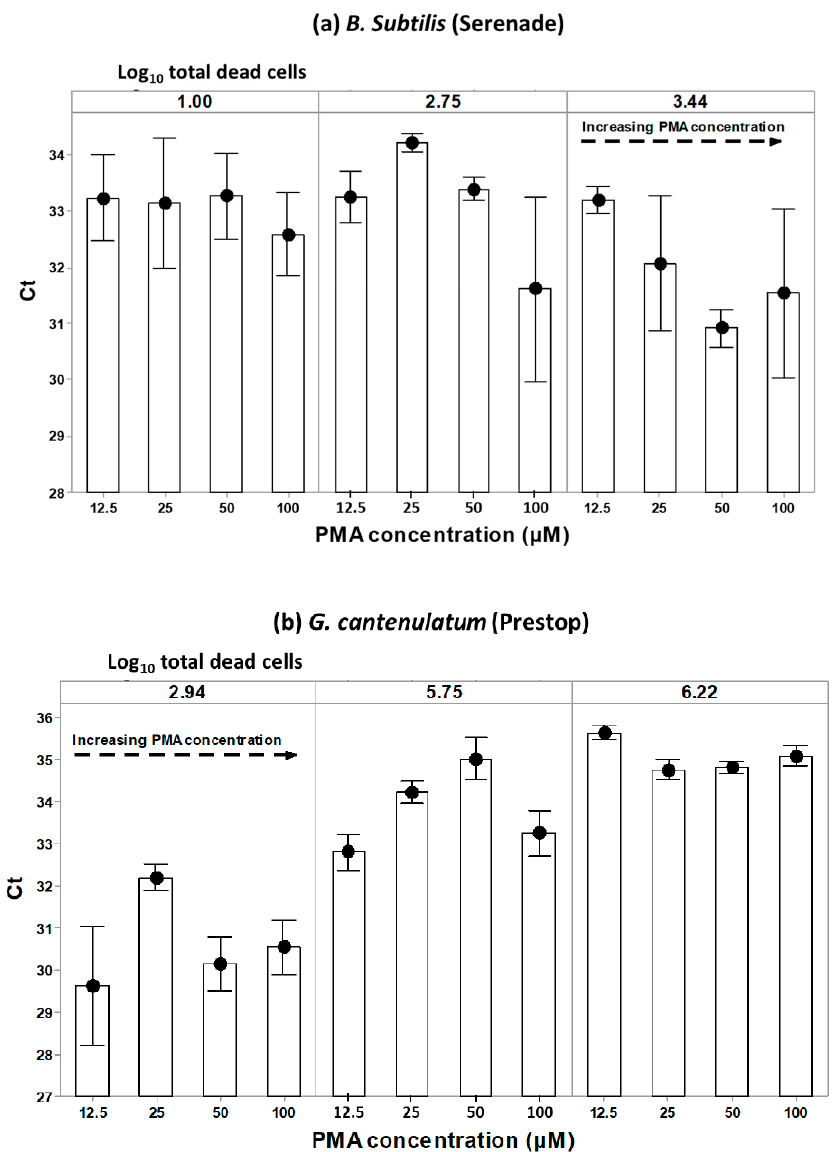
Figure 4. ( a ). Dose response of cycle threshold (Ct) to increasing PMAxx™ concentrations on the same total numbers of B. subtilis dead cells; ( b ) Dose response of cycle threshold (Ct) to increasing PMAxx™ concentrations on the same total numbers of G. catenulatum dead cells. The points show the mean of two independent biological experiments carried out with three replicates for the qPCR plate. The bars represent the standard error. The detection limit was Ct < 35.